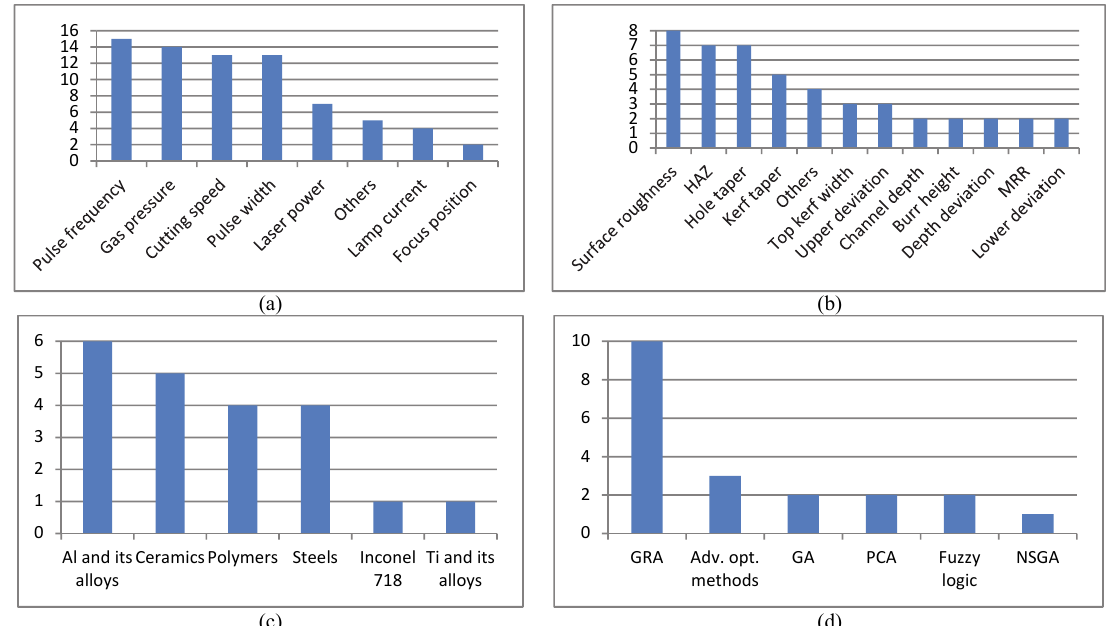
Fig. 4 Analysis on the parametric optimization of LBM